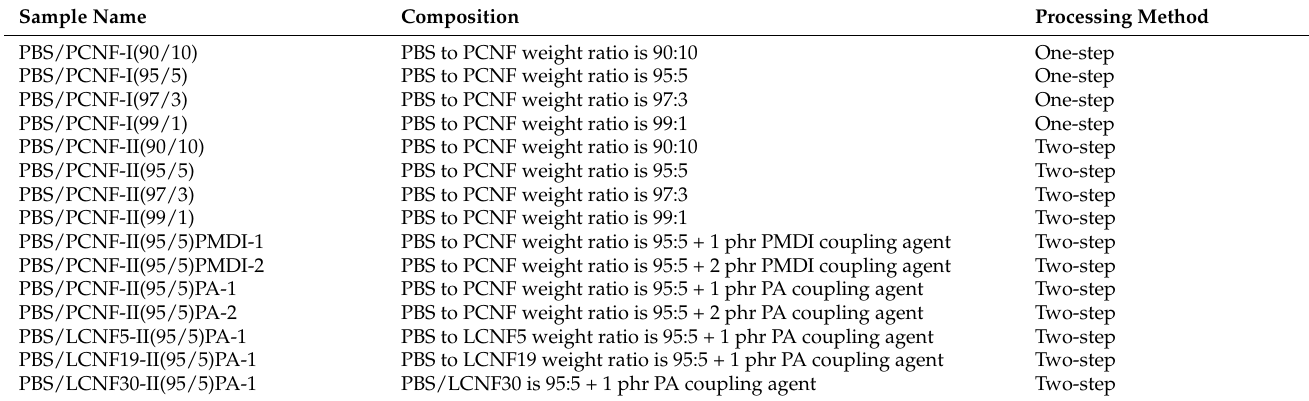
Table 2. Sample names in reference to their composition and processing